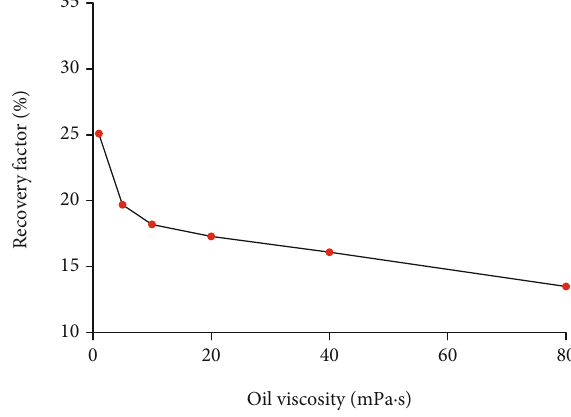
Figure 4: Ultimate recovery factors of reservoirs with di ff erent oil viscosities by cyclic surfactant